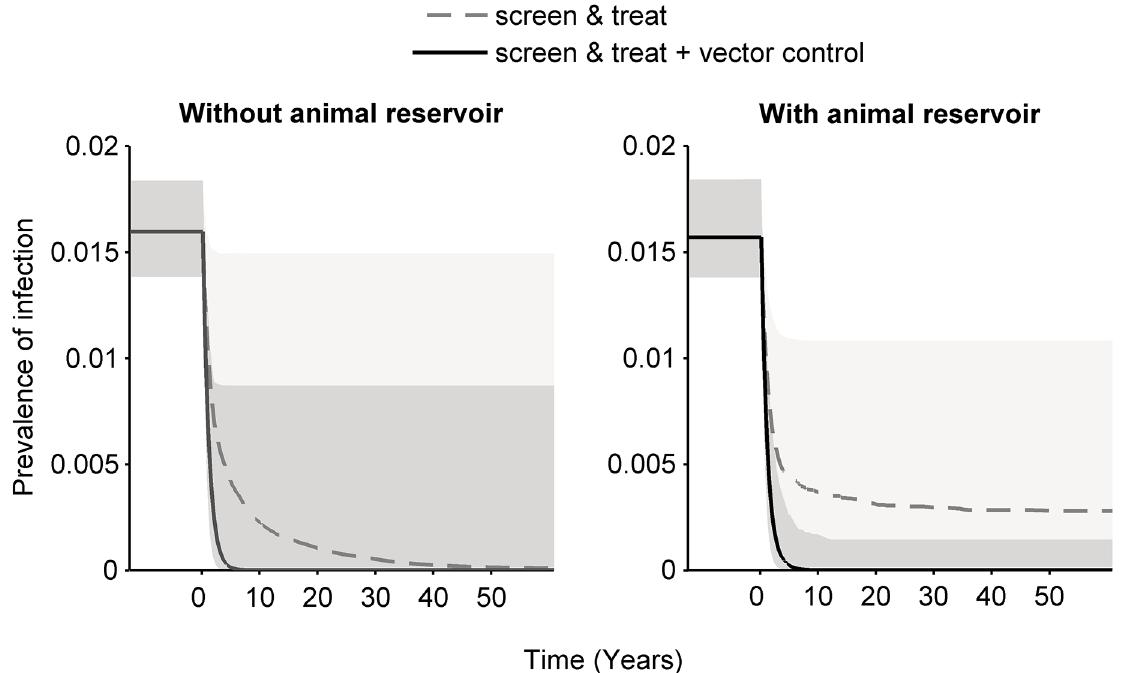
Fig 4. Median (lines) and 95 th percentiles (shaded areas) of simulations on the impact of interventions on prevalence over time in high transmission settings without (left) and with (right) animal-tsetse transmission, assuming a range of efficacies for screen & treat (solid line) and screen & treat with vector control (dashed